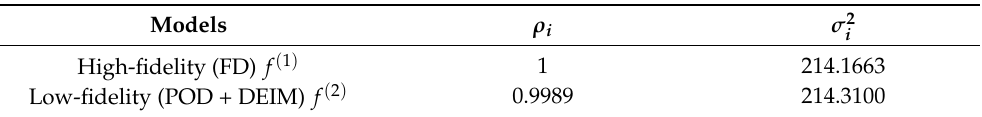
Table 2. The Pearson correlation coefficient and variances of high- and low-fidelity models for NLS